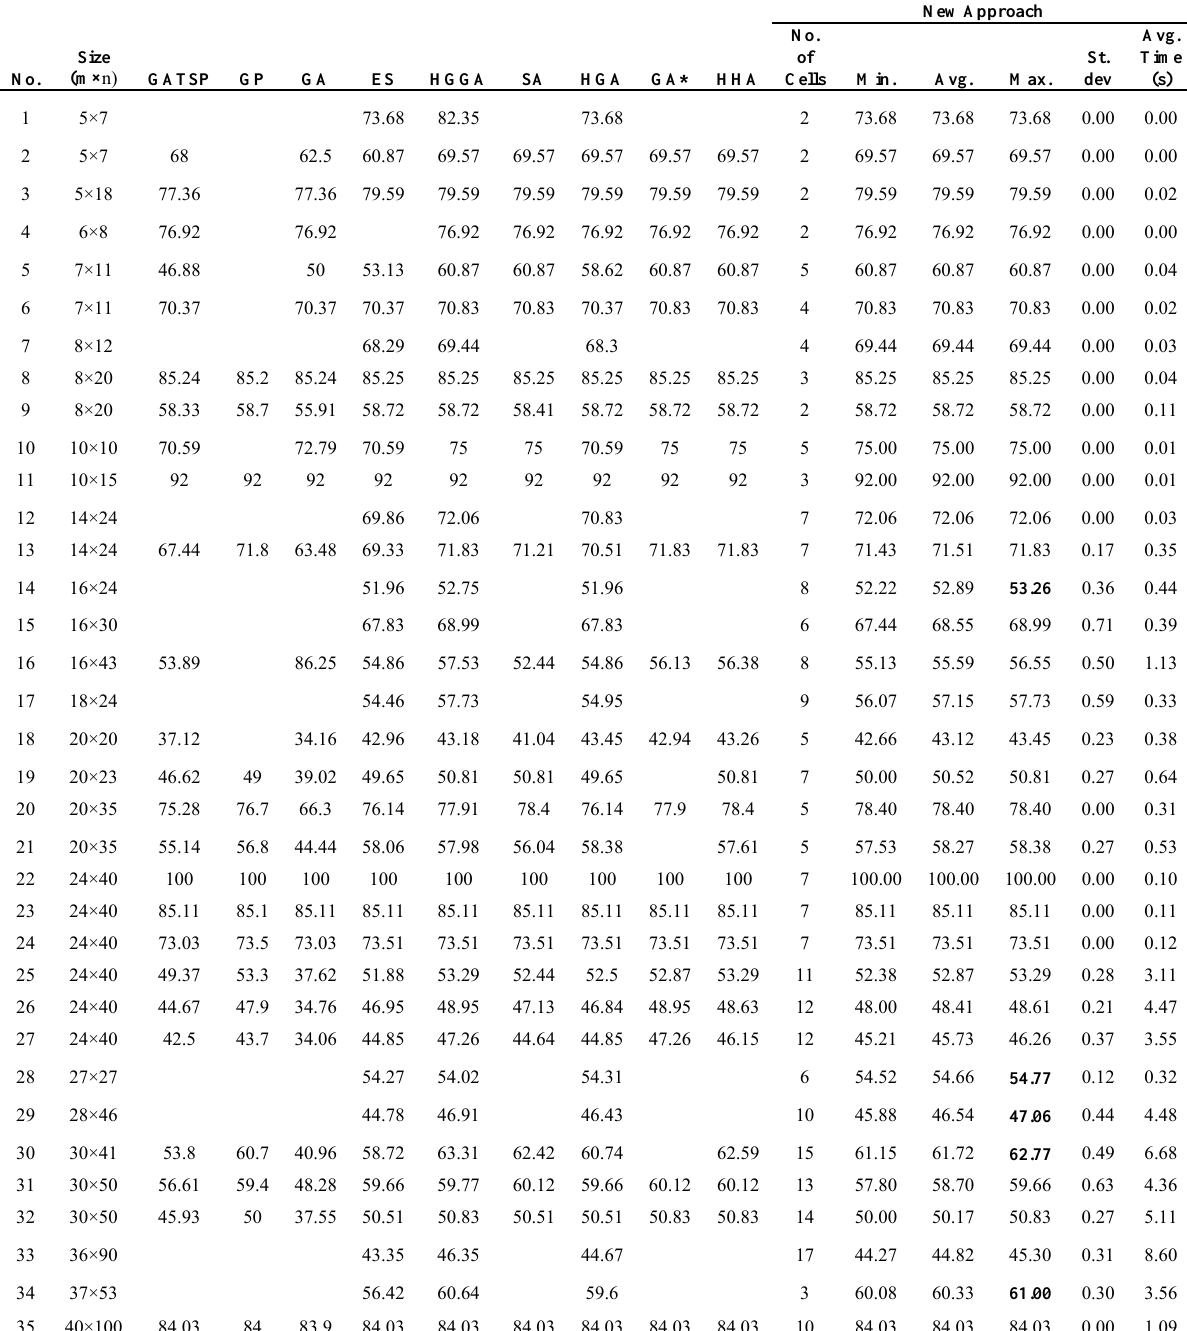
Table 2. Results in the case where singletons are